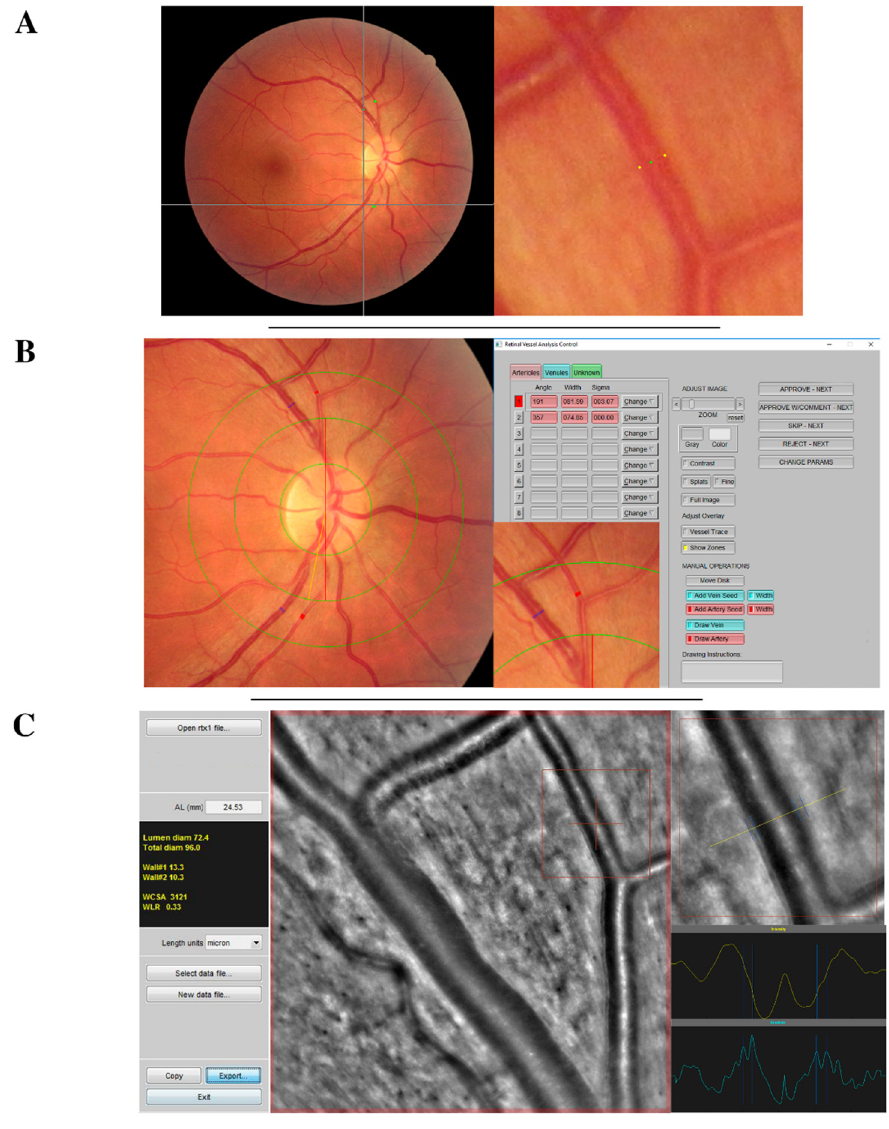
Figure 1. Acquisition interface of retinal vessel measurements ( A ) using vessel analysis using VAM- PIRE annotation tool, ( B ) IVAN software, or ( C ) adaptive optics camera and AO_Detect_Artery™. This figure briefly presents the acquisition interface of each vessel measurement technique that has been systematically used to measure four vessels (the two temporal arteries and the two temporal veins) of each retinal photograph. Vessel measurements were performed at the same section with all software tools. In this example the measured section of the superior temporal artery is framed in